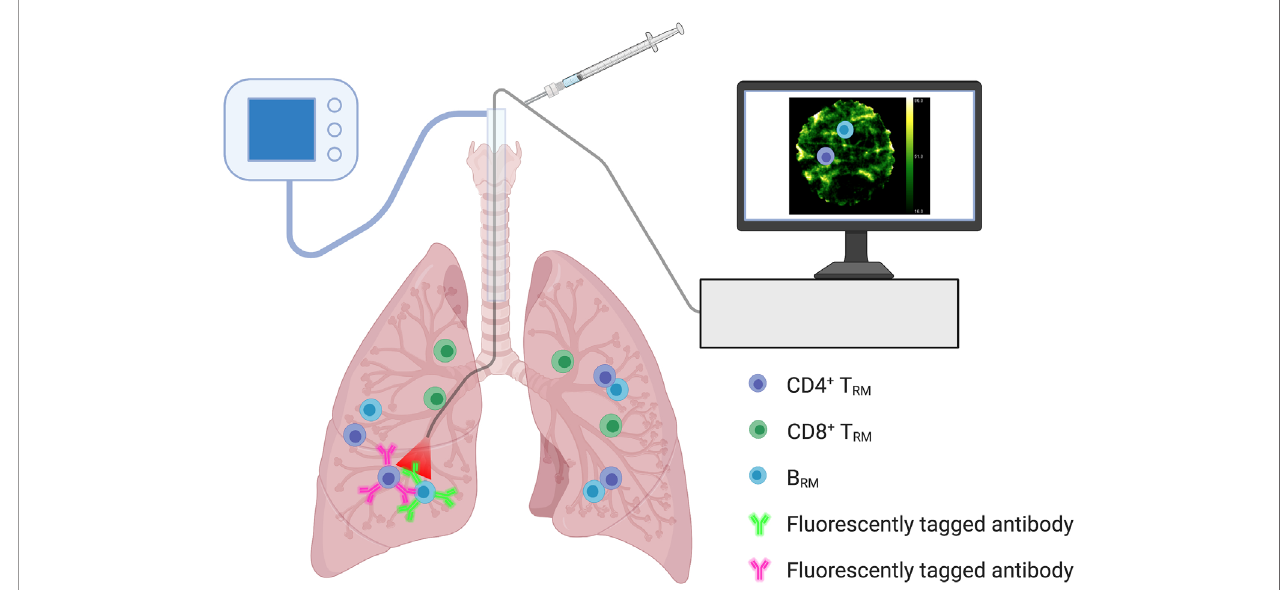
FIGURE 3 | In Situ Optical Imaging of Resident Memory Lymphocytes. Optical endomicroscopy imaging within the lungs may allow for the in situ detection and quanti fi cation of resident memory lymphocyte populations. Monitoring numbers following immunization may help re fl ect vaccine ef fi cacy and immunological memory. Fluorescently tagged ligands or antibodies, capable of binding to speci fi c T RM /B RM surface markers, can be delivered to the airways via a bronchoscope to enable visualisation. Using a combination of fl uorescent ligands/antibodies could help differentiate resident memory lymphocyte